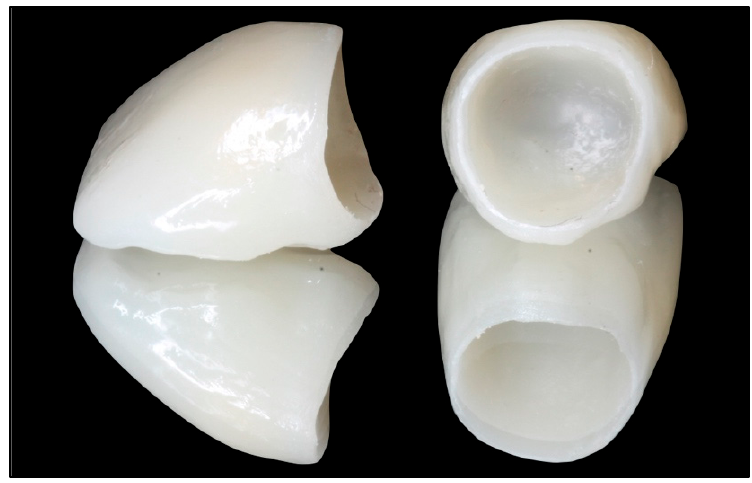
Figure 2. Prosthetic emergence profile of provisional restorations that will seal the clot and favor periodontal healing.